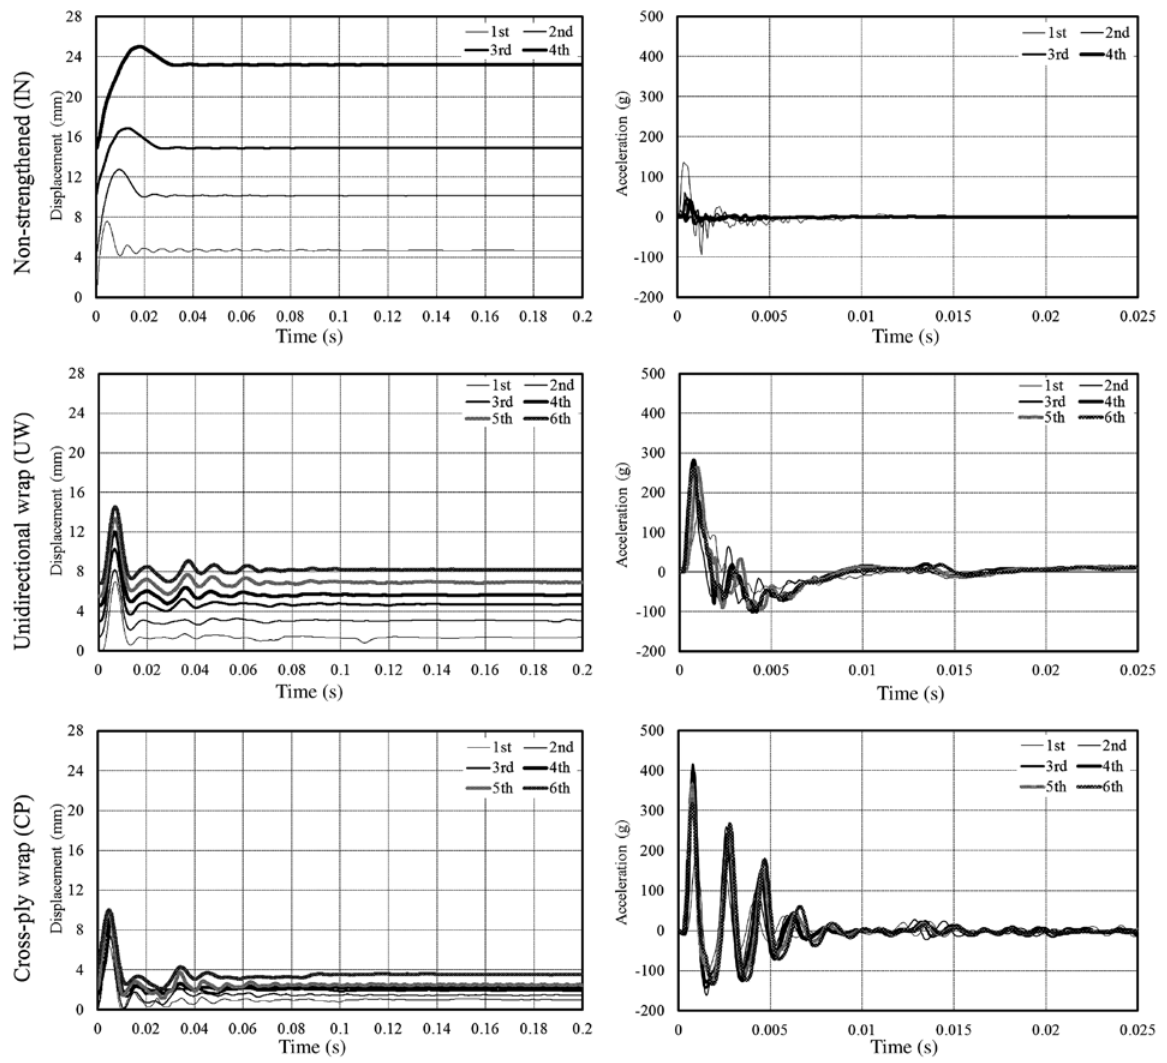
Figure 4: Midspan deflection and acceleration time history